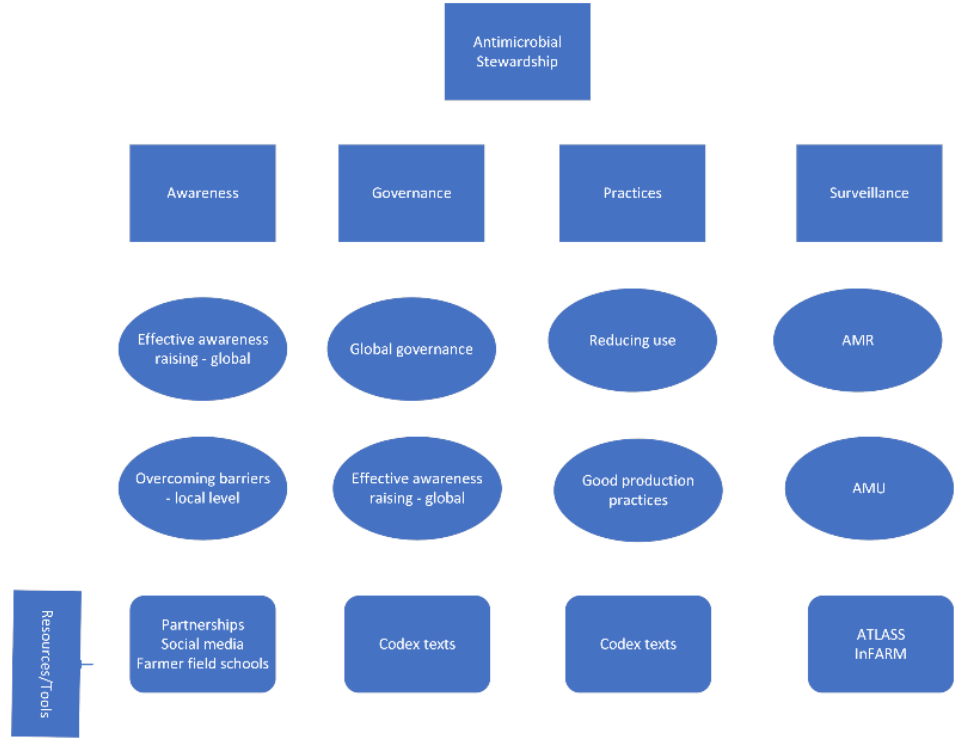
Figure 1. Key supporting pillars for antimicrobial stewardship.